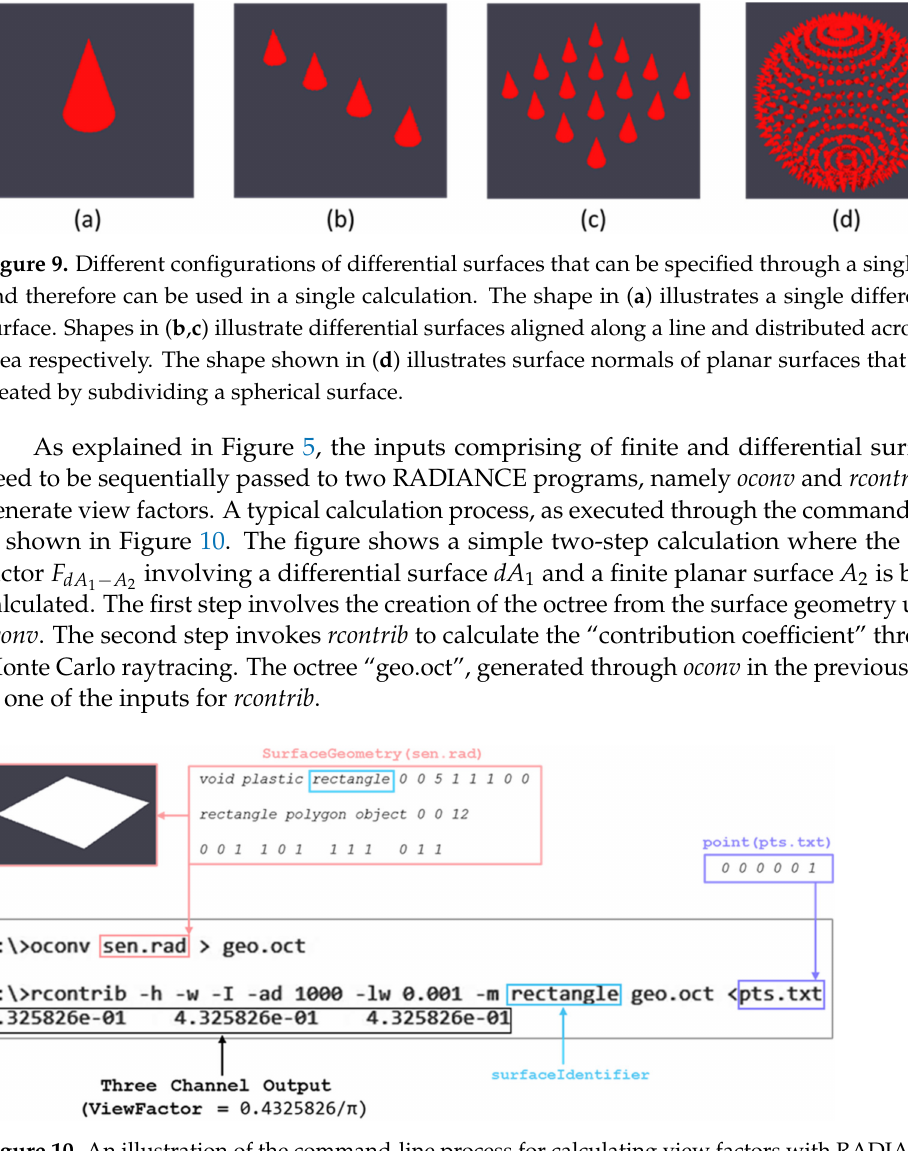
Figure 10. An illustration of the command-line process for calculating view factors with